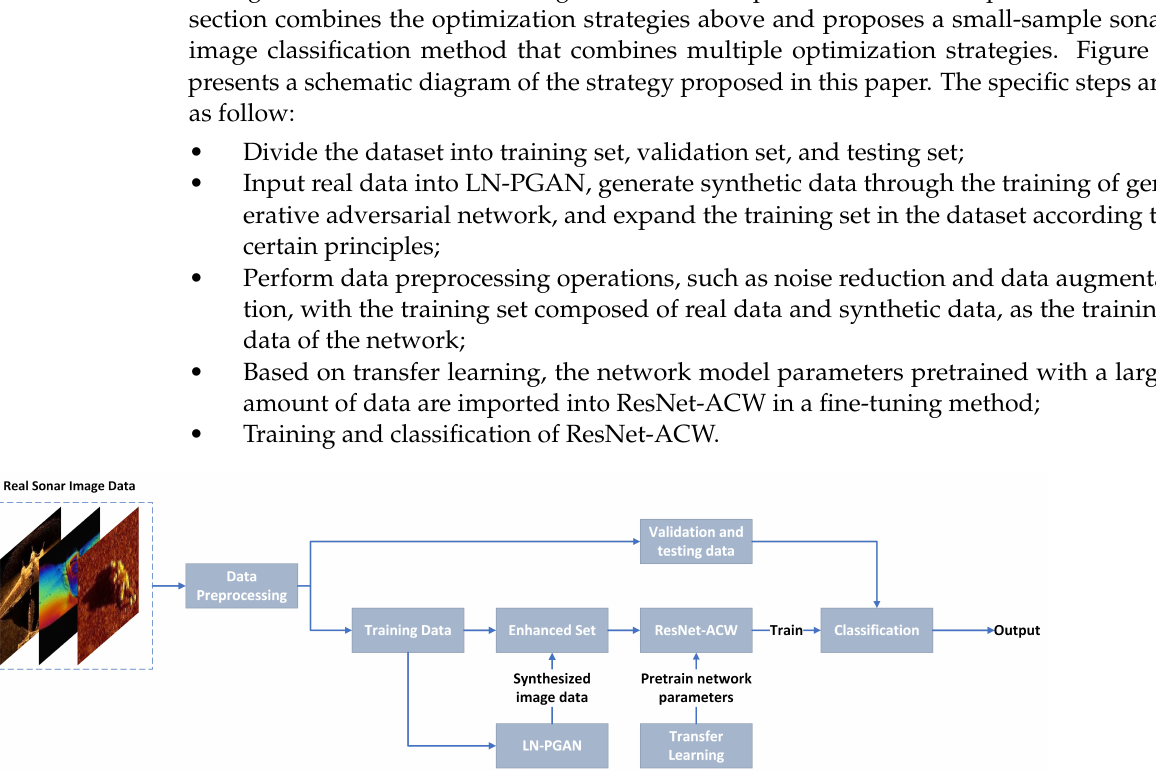
Figure 9. Flow of the fusion few-shot